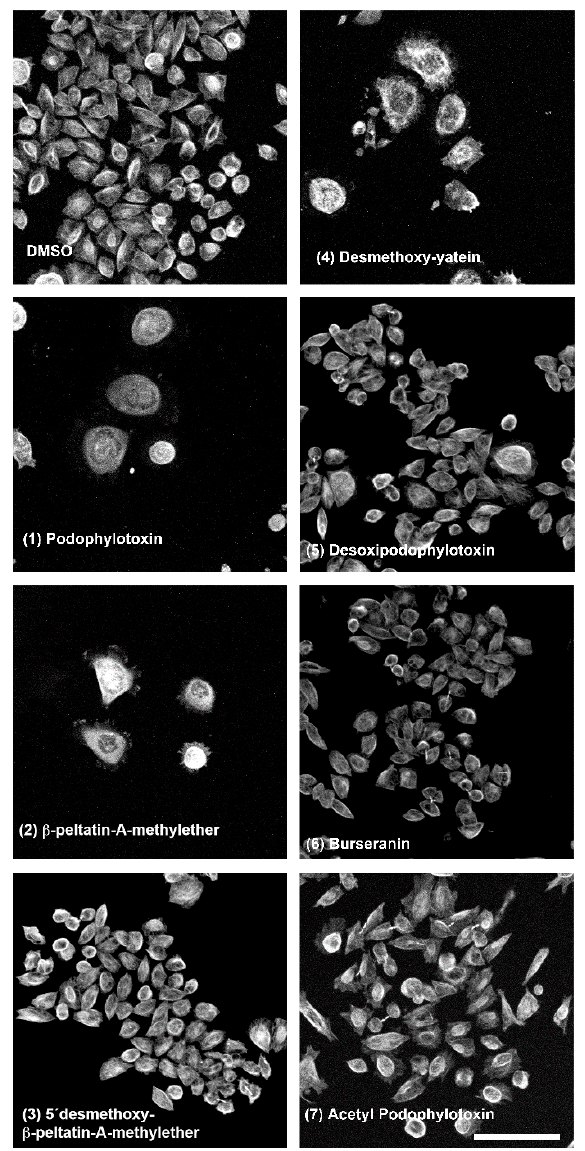
Figure 6. Whole-mount immunolocalization of cancer PC3 cells microtubules as viewed by confocal microscopy after treatment with DMSO (control) and lignans ( 1 )–( 7 ). Scale bar, 100 µm.